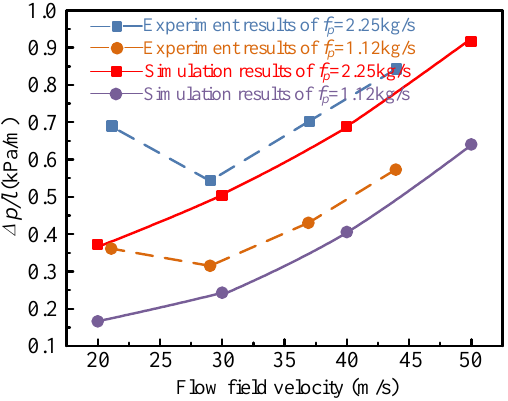
Figure 8. Comparison of pressure drop between experiment and simulation.